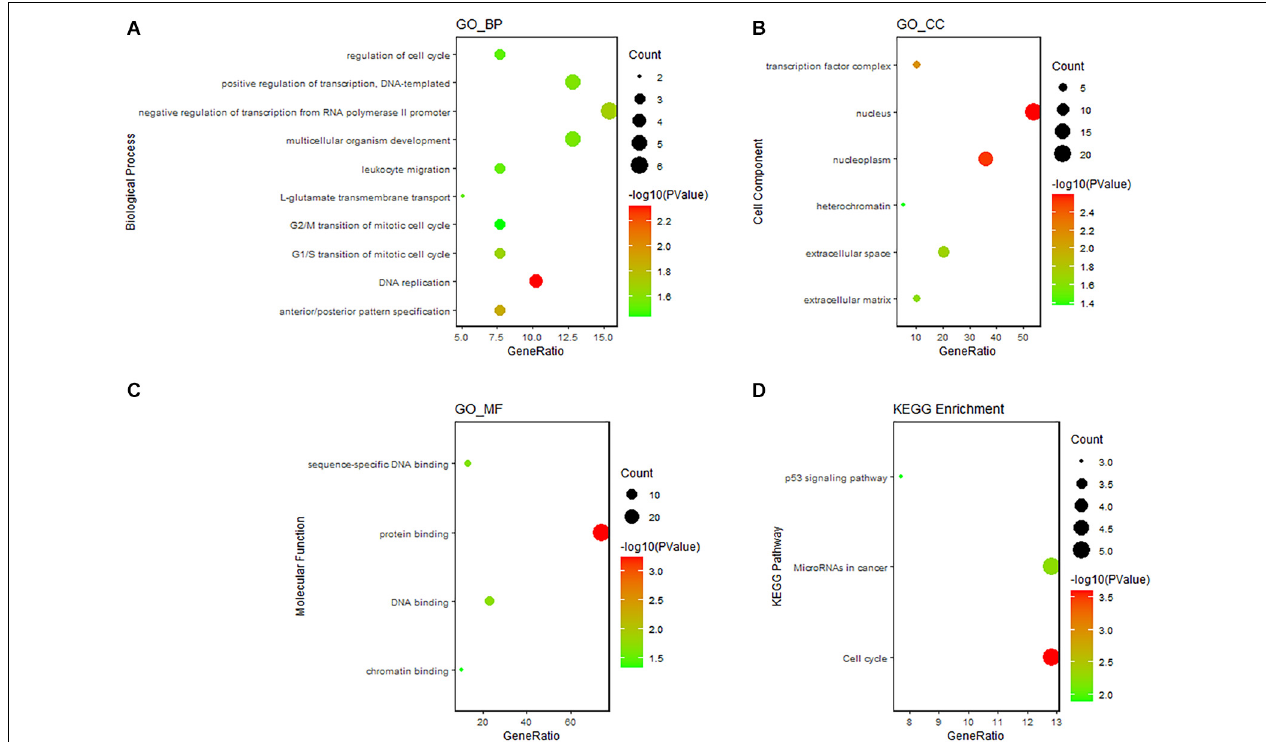
FIGURE 5 | GO and KEGG enrichment analysis of DEmRNAs in the ceRNA network. (A) Bubble Plot of BP. (B) Bubble Plot of CC. (C) Bubble Plot of MF. (D) Bubble Plot of KEGG. GO, Gene Ontology; BP, biological processes; CC, cell component; MF, molecular function.